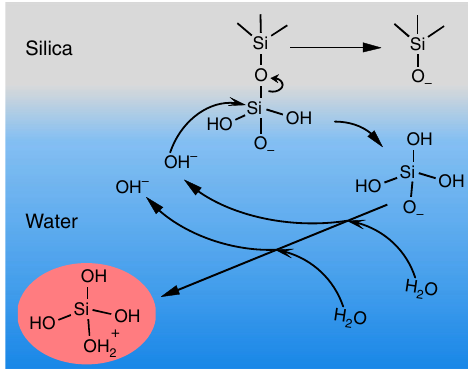
Fig. 5 Proposed dissolution mechanism of silica in water considering hydrolysis with hydroxide ions. With each reaction cycle, protonation of the dissolved silicic acid molecule releases two hydroxide ions close to the surface which are mostly consumed by the hydrolysis reaction, giving rise to an auto-catalytic